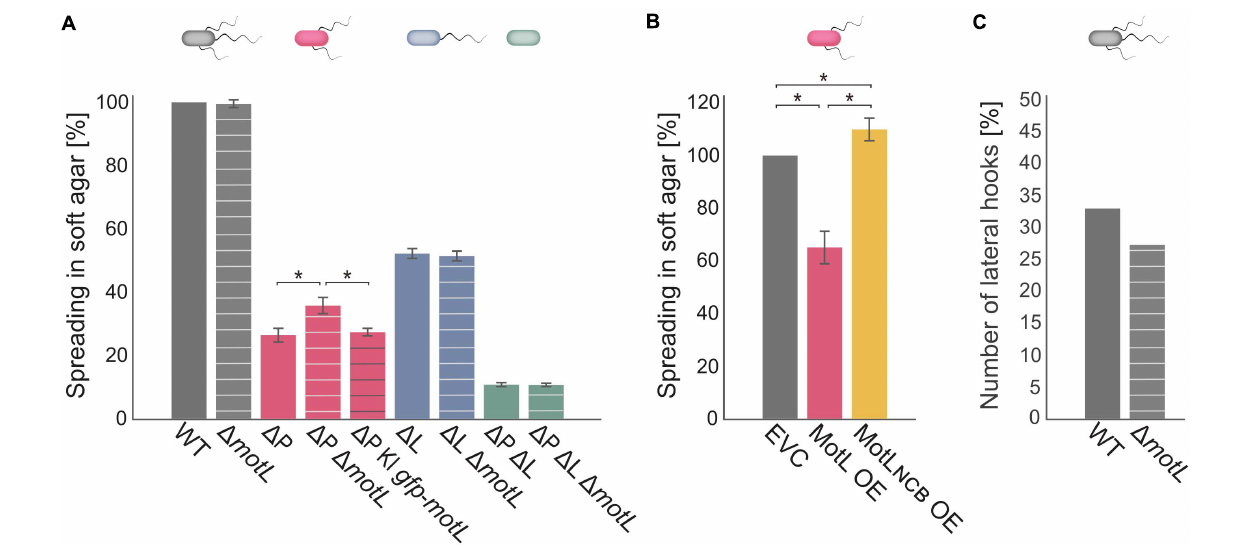
FIGURE 3 | MotL affects the S. putrefaciens lateral, but not the polar, flagella. (A) Flagella-mediated spreading through soft agar after deletion (and complementation) of motL. The corresponding background strains had both the polar and lateral flagella (gray), only one each [ (cid:49) P lacking the polar filament (red); (cid:49) L lacking the lateral filament (blue) or no flagella (green) as indicated by the cartoon cells above the bars]. The white cross bands indicate the strains in which motL was deleted, black cross bars indicate the strain bearing gfp-motL . (B) Lateral flagella-mediated spreading upon ectopic overproduction (OE) of GFP-MotL and the corresponding mutant not binding c-di-GMP (GFP-MotL NCB ). EVC, empty-vector control. (A,B) are the results of three independent experiments. The bars with the asterisks indicate significant differences according to ANOVA. (C) Effect of motL deletion on the presence of lateral hooks as a proxy for the number of functional lateral flagella in cells growing exponentially in the LB medium. See text and methods for the hook staining procedure. The numbers are deduced from observing 430 cells for WT and 431 for motL deletion in four independent experiments. The difference is not significant according to the Pearson’s Chi-squared test with Yates’ continuity correction